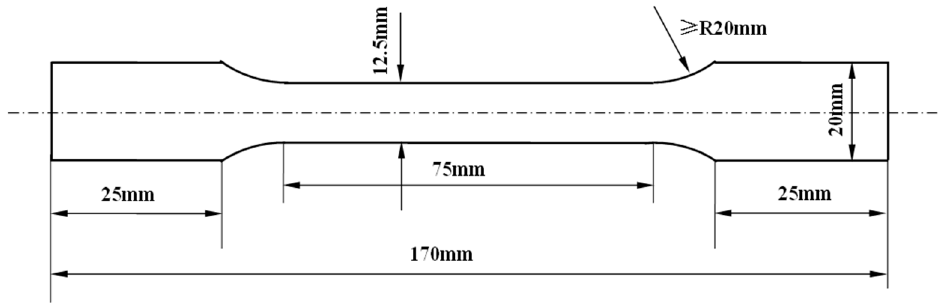
Figure 1. Dimensions of the tensile specimens.